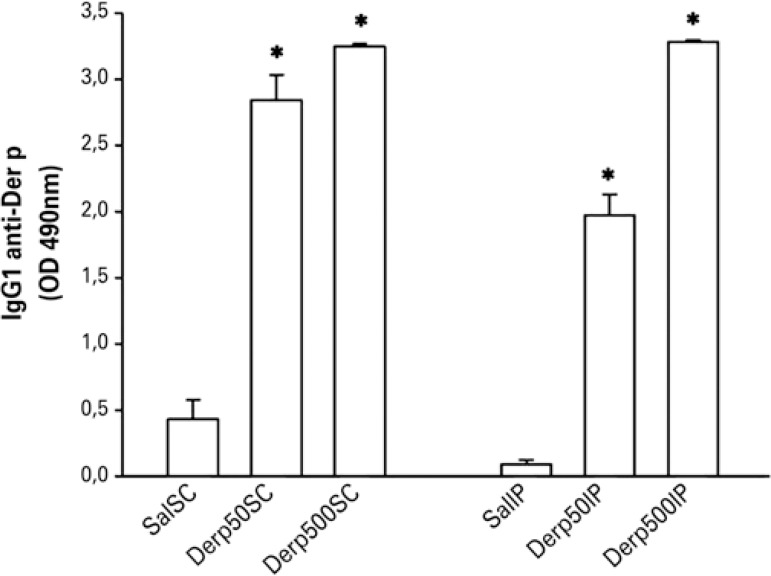
Valores de média ± erro padrão da titulação da IgG1 específica anti- Dermatophagoides pteronyssinus pela técnica da ensaio imunoenzimático (ELISA)